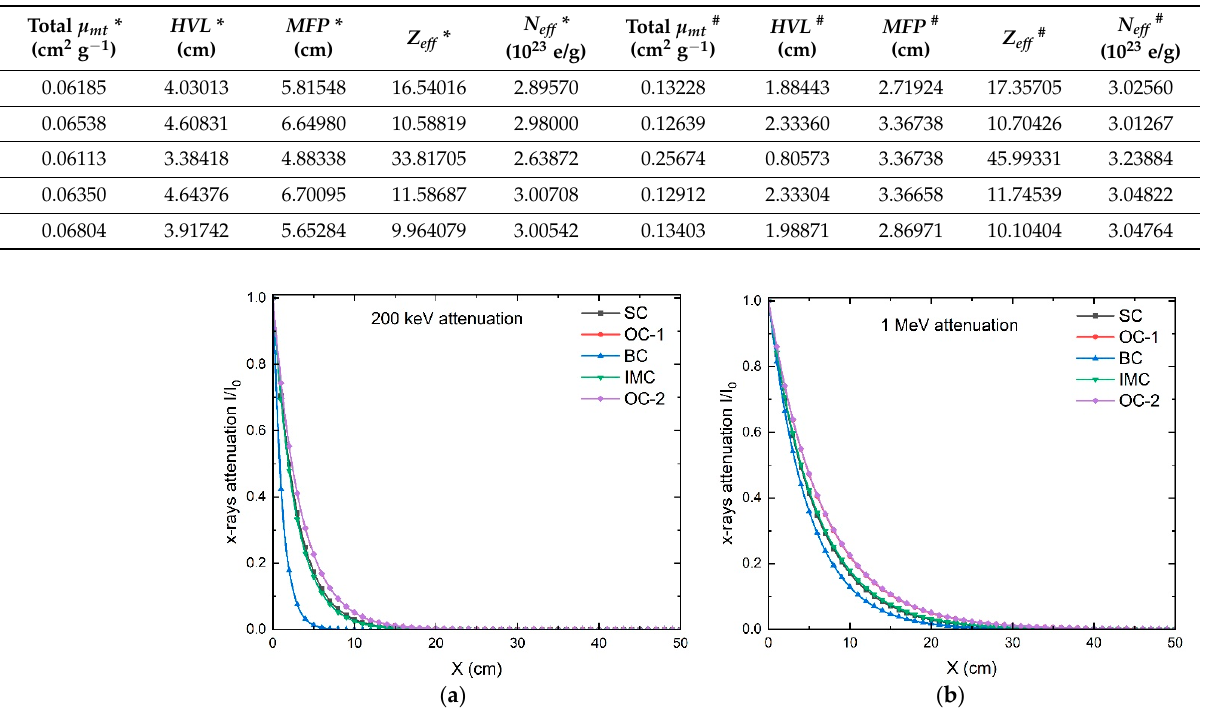
Figure 4. The attenuation of X-rays in the investigated concrete materials using Equation (5) at X-ray energies of ( a ) 0.2 MeV and ( b ) 1 MeV.